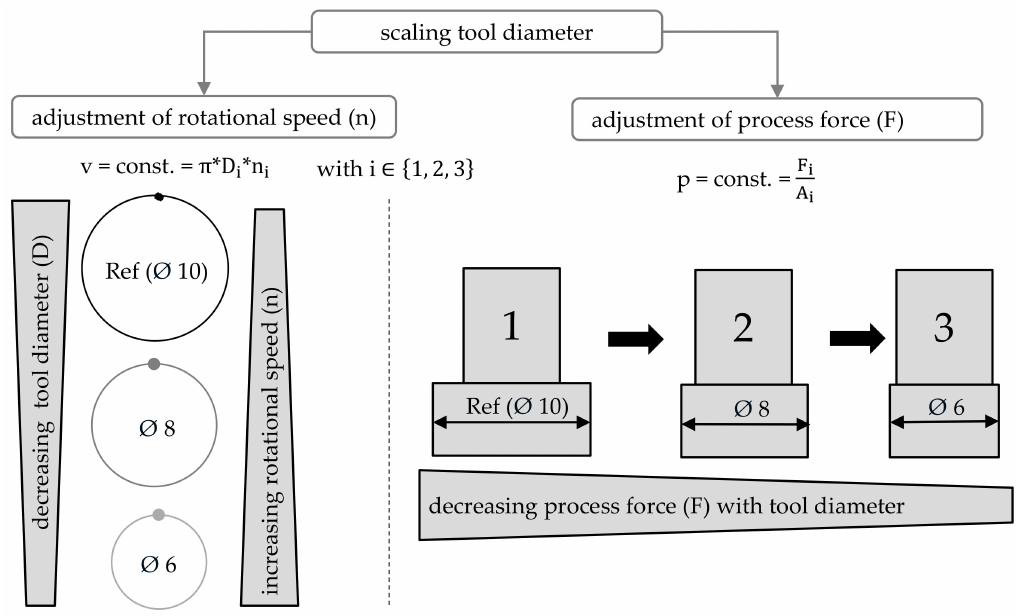
Figure 4. Tool downscaling strategy with constant circumferential speed (v) and surface pressure